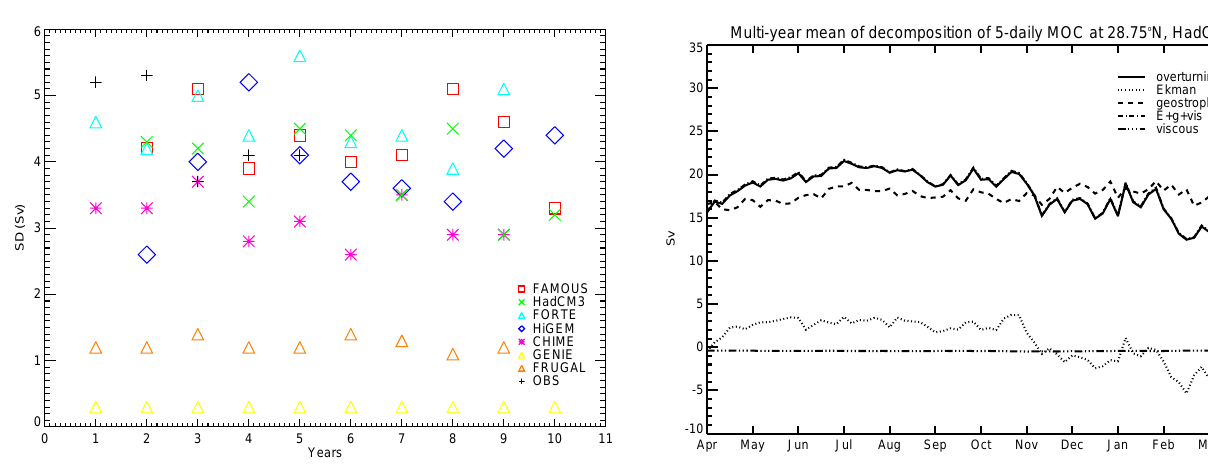
Fig. 4. Decomposition of 5-daily Atlantic MOC ( T over ) into phys- Figure 4: Decomposition of 5-daily Atlantic MOC ( T over ) into physical components at ical components at about 29 ◦ N in HadCM3. The sum E + g + vis about 29 o N in HadCM3. The sum E+g+vis (dash-dotted) is almost coincident with the (dash-dotted) is almost coincident with the total overturning total overturning (solid).